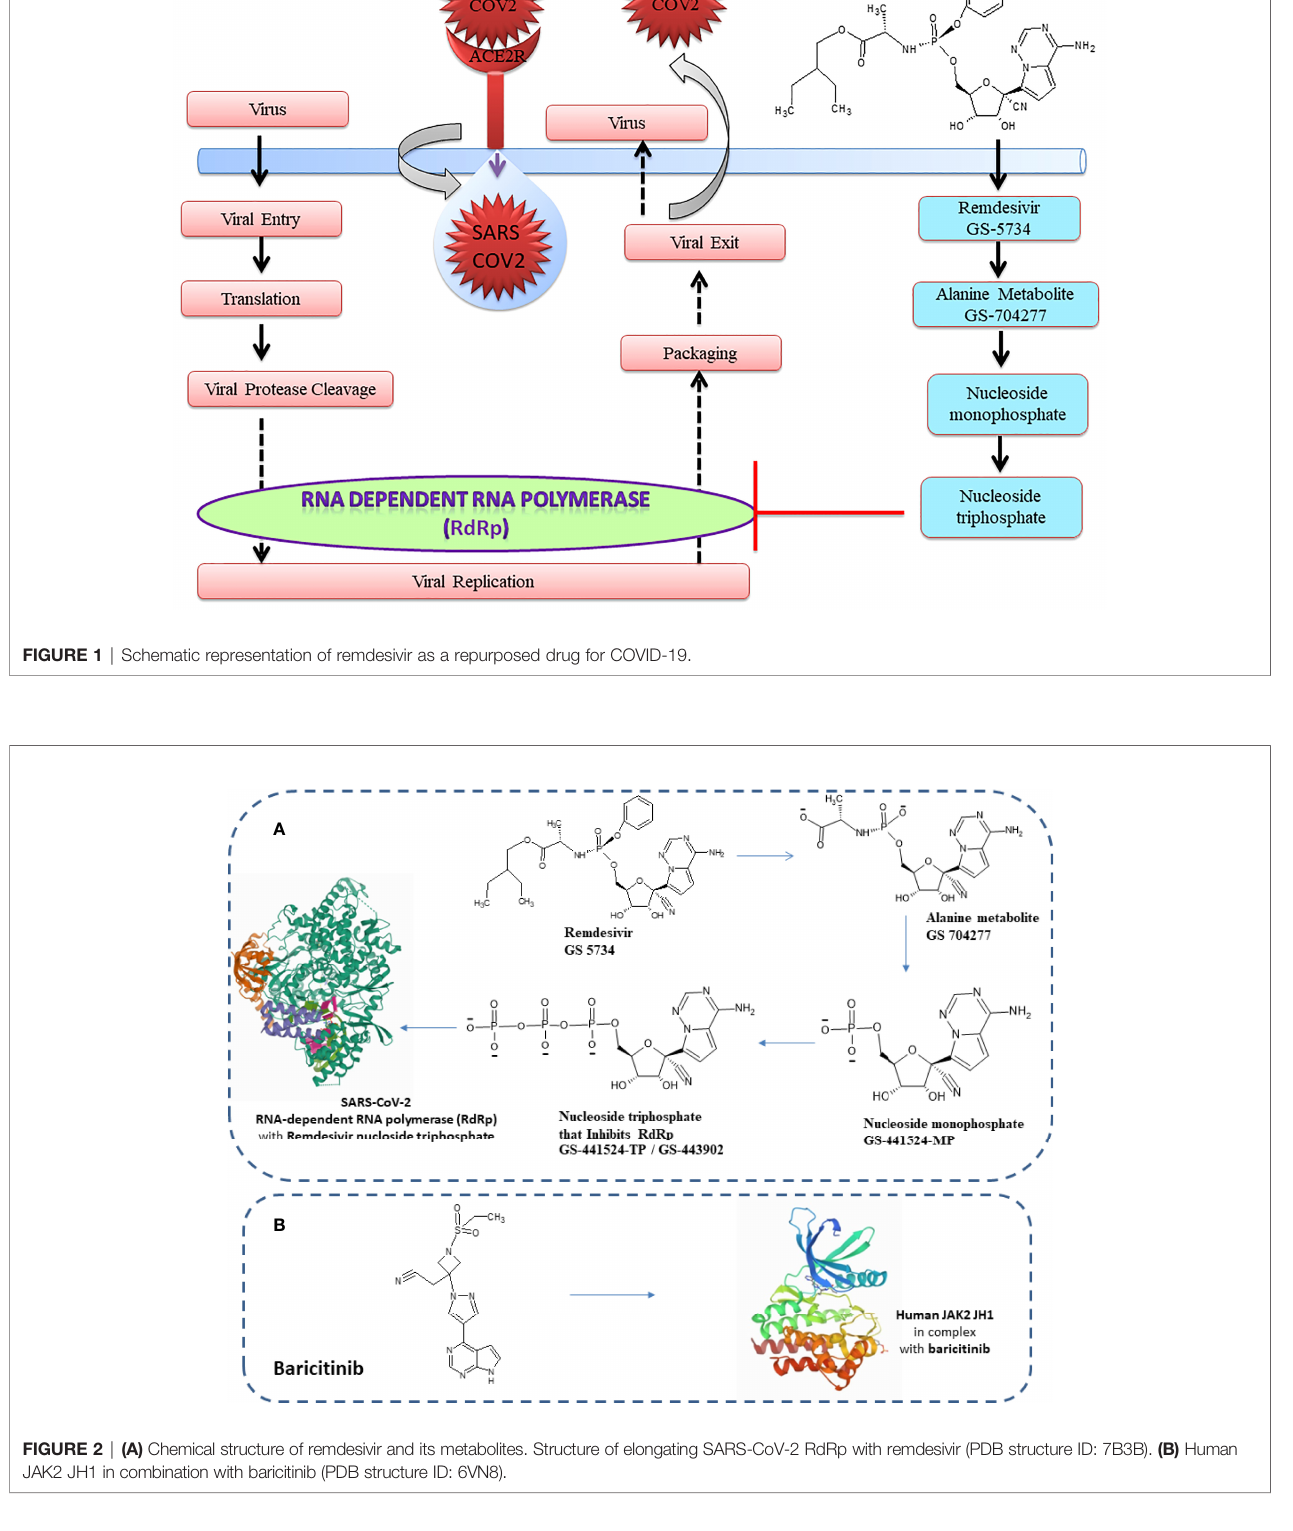
FIGURE 2 | (A) Chemical structure of remdesivir and its metabolites. Structure of elongating SARS-CoV-2 RdRp with remdesivir (PDB structure ID: 7B3B). (B) Human JAK2 JH1 in combination with baricitinib (PDB structure ID: